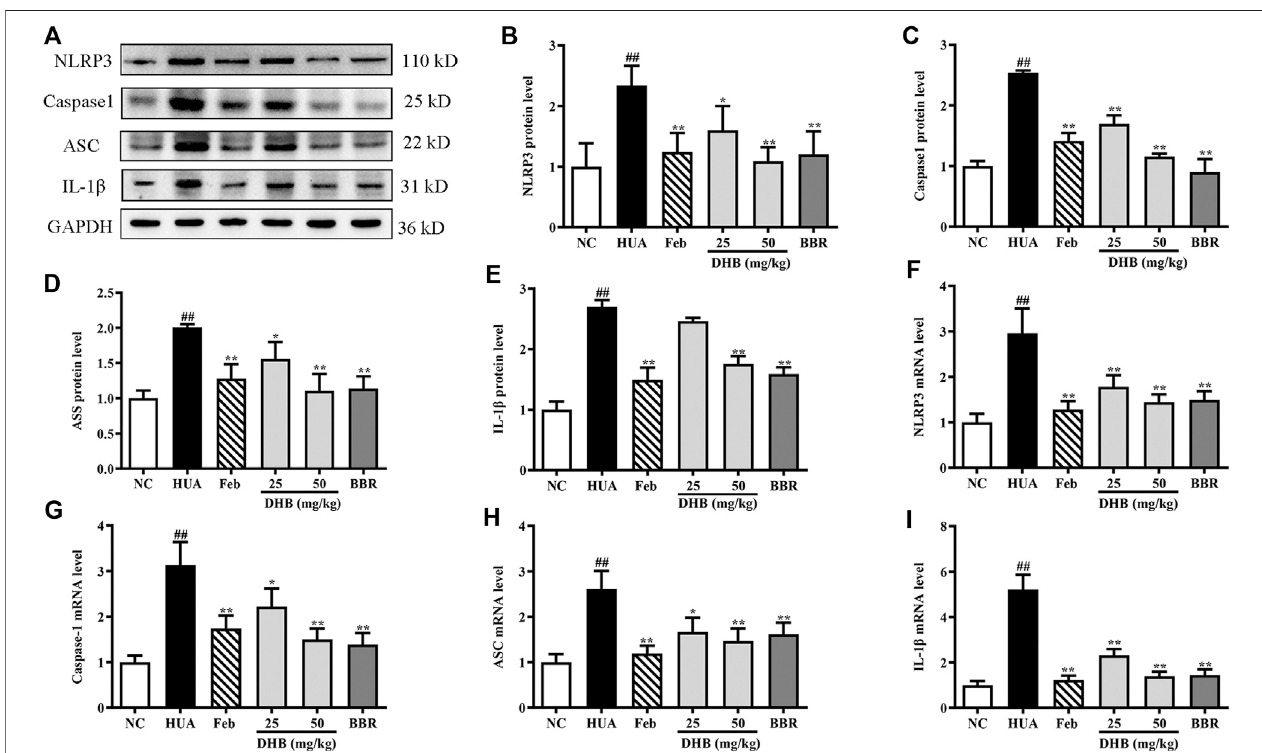
FIGURE 7 | Effect of DHB on NLRP3 in fl ammasome signaling in p O/HX-induced hyperuricemic mice. (A) Representative Western blot bands; The protein expression of (B) NLRP3, (C) caspase-1, (D) ASC, (E) IL-1 β ; the gene expression of (F) NLRP3, (G) caspase-1, (H) ASC, (I) IL-1 β ; Protein levels were determined by Western blotting and the band optical densities were quantitated by Image J software. The renal protein levels were normalized to GAPDH. Relative gene levels were determinedbyRT-qPCR.Theresultsareexpressedasmean ± SD(n (cid:2) 3 – 5). # p < 0.05, ## p < 0.01,comparedwithNCgroup; *p < 0.05, **p < 0.01,comparedwith HUA